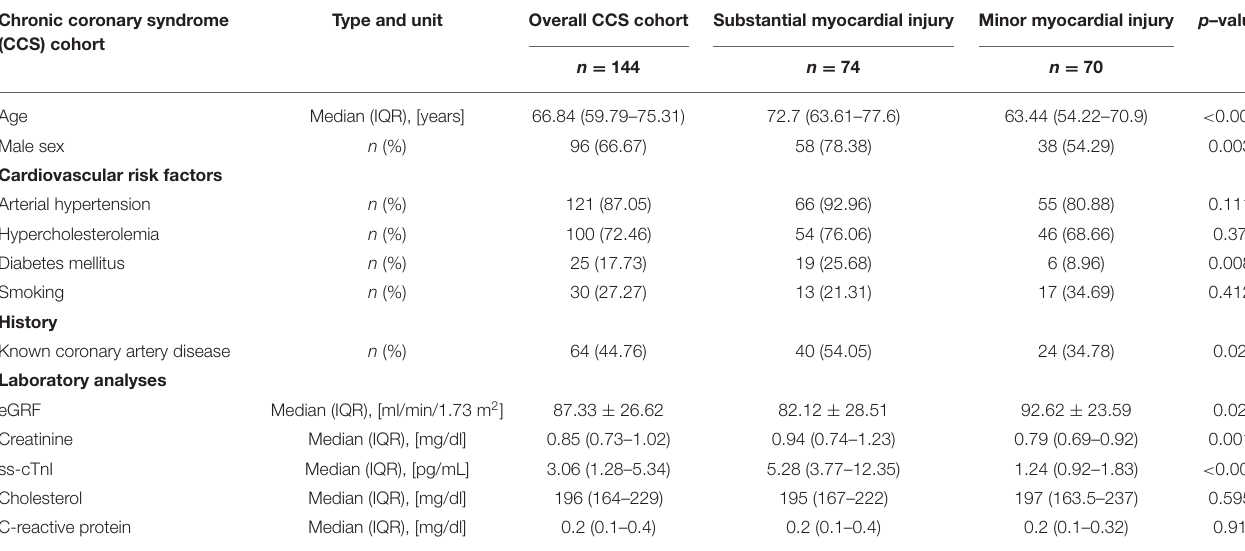
TABLE 2 | Baseline characteristics of the chronic coronary syndrome (CCS)